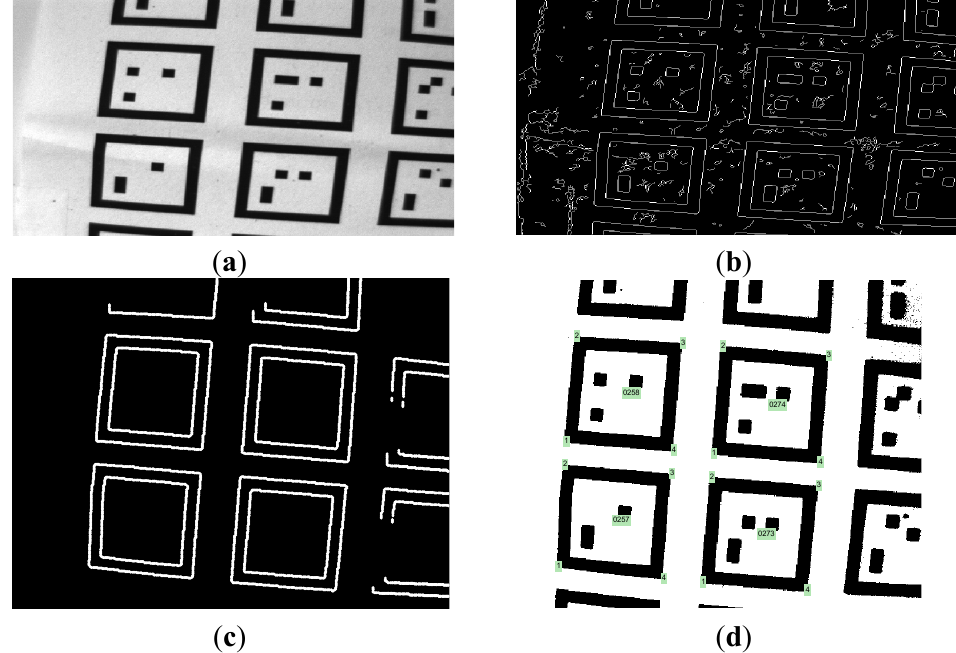
Figure 5. Image processing steps including ( a ) Origin gray scale image; ( b ) Detected contours using Canny edge detector; ( c ) Quadrilateral contours; and ( d ) Marker IDs and four